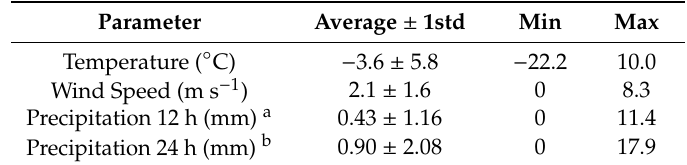
Table 3. Meteorological parameters at the Diabła G ó ra field site. Average values, standard deviations (std), minimum and maximum values for 17 January–19 March